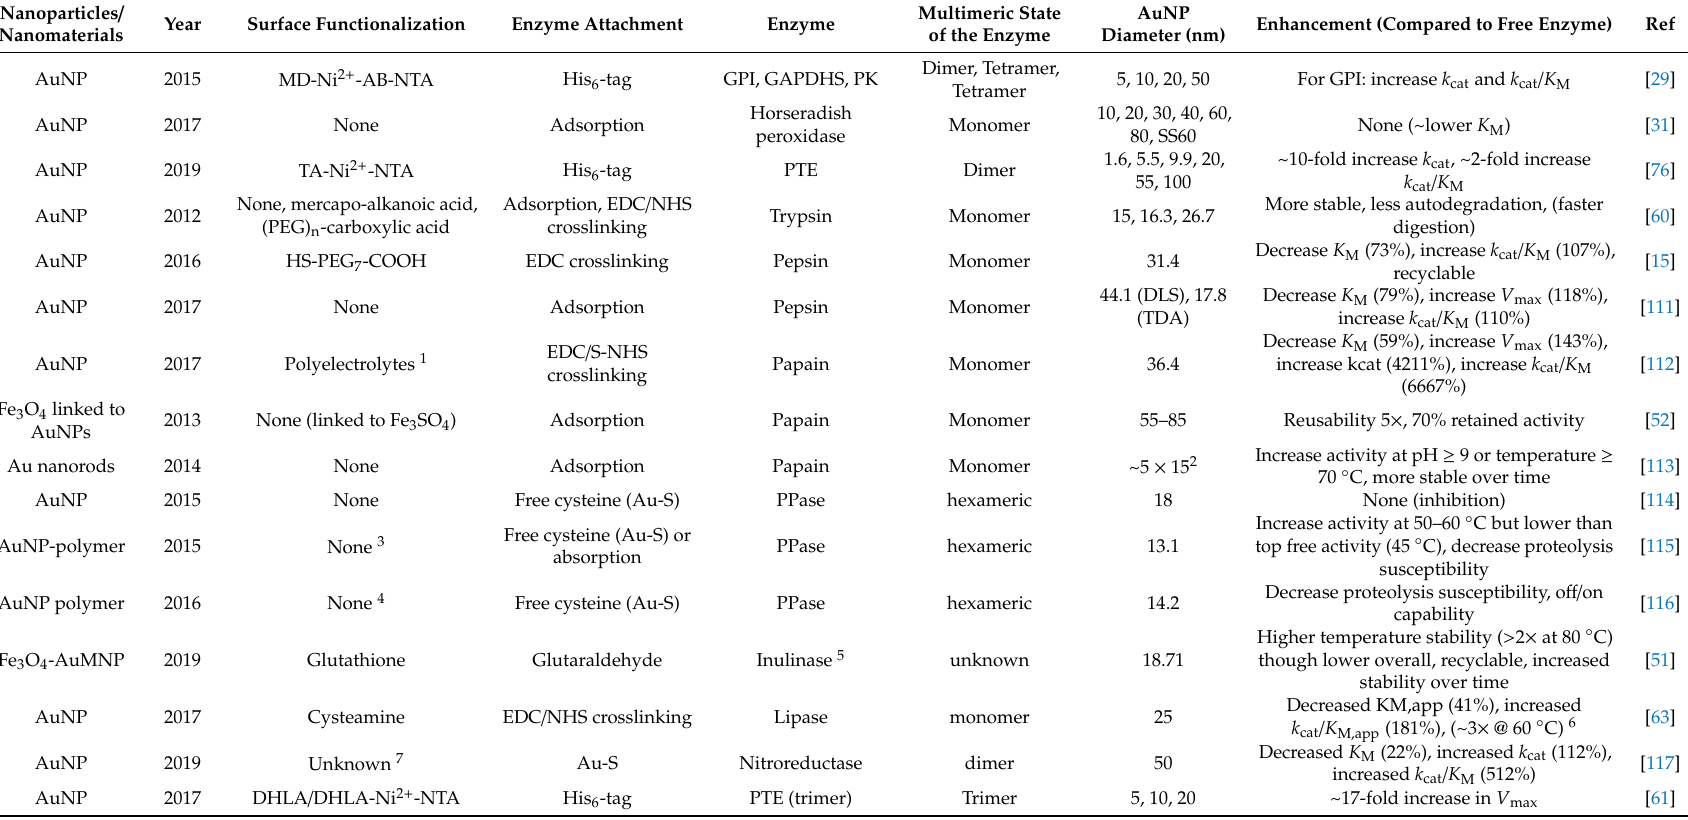
Table 7. Overview of representative AuNP-immobilized